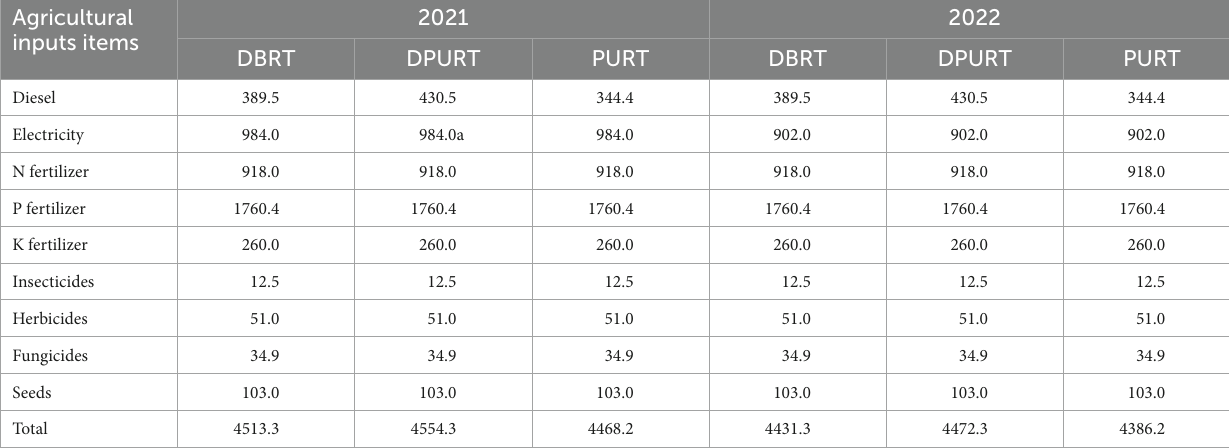
TABLE 4 GHG emissions (kg CO 2 -eq ha − 1 ) from agricultural inputs in the three tillage treatments in 2021 and 2022. Agricultural inputs